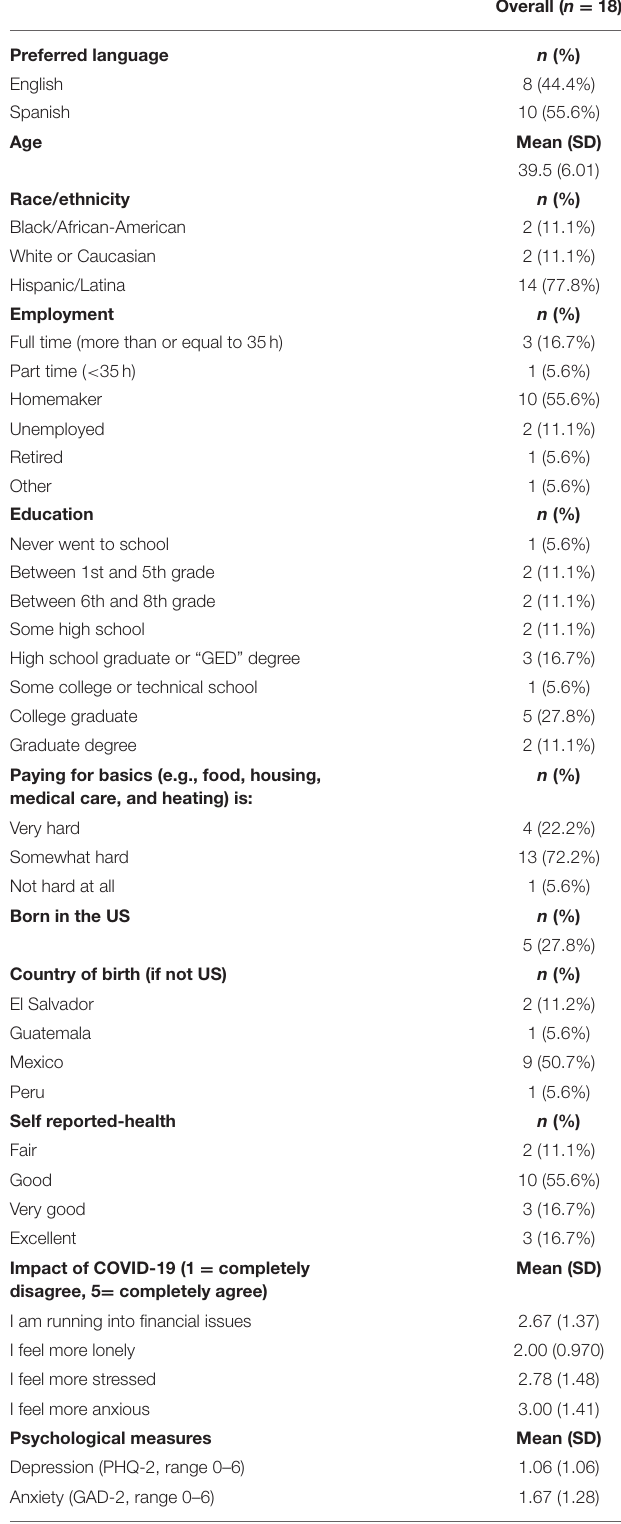
TABLE 1 | Participant